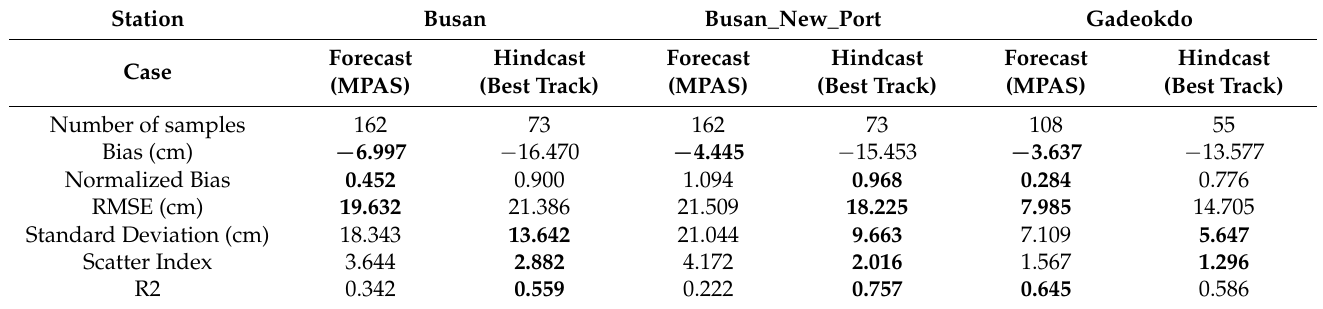
Table 7. Same as Table 5, except for storm surge heights.